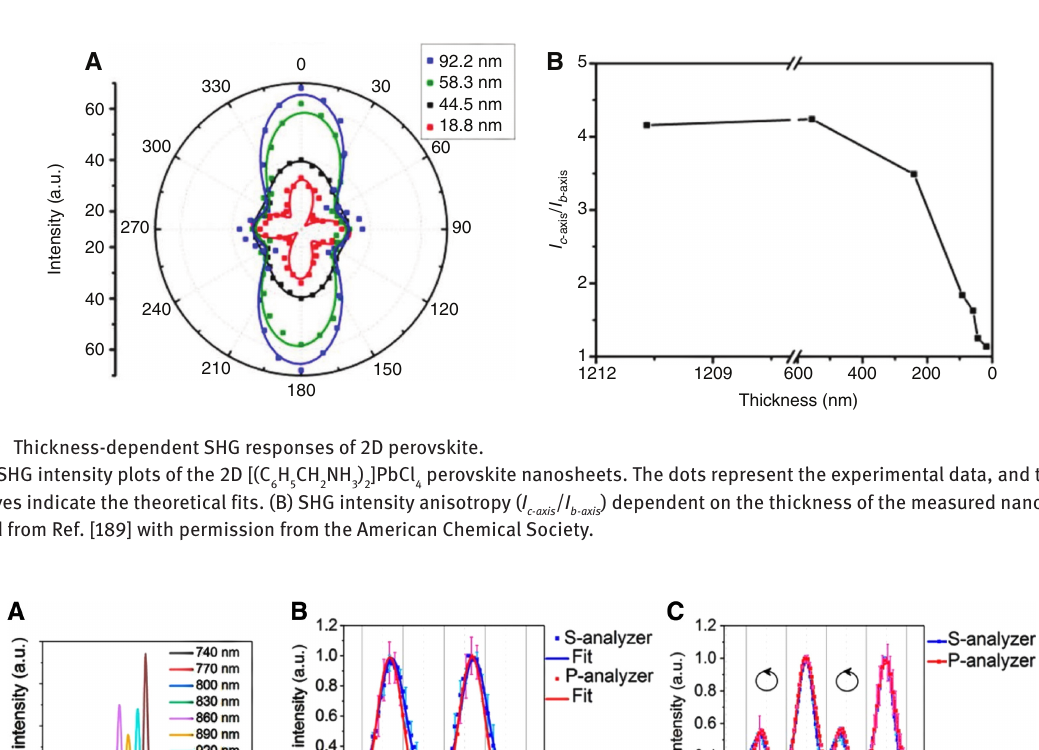
Figure 16: NLO characteristics of the chiral ( R -MPEA) (A) Normalized NLO spectra of a ( R -MPEA) oriented ( R -MPEA)